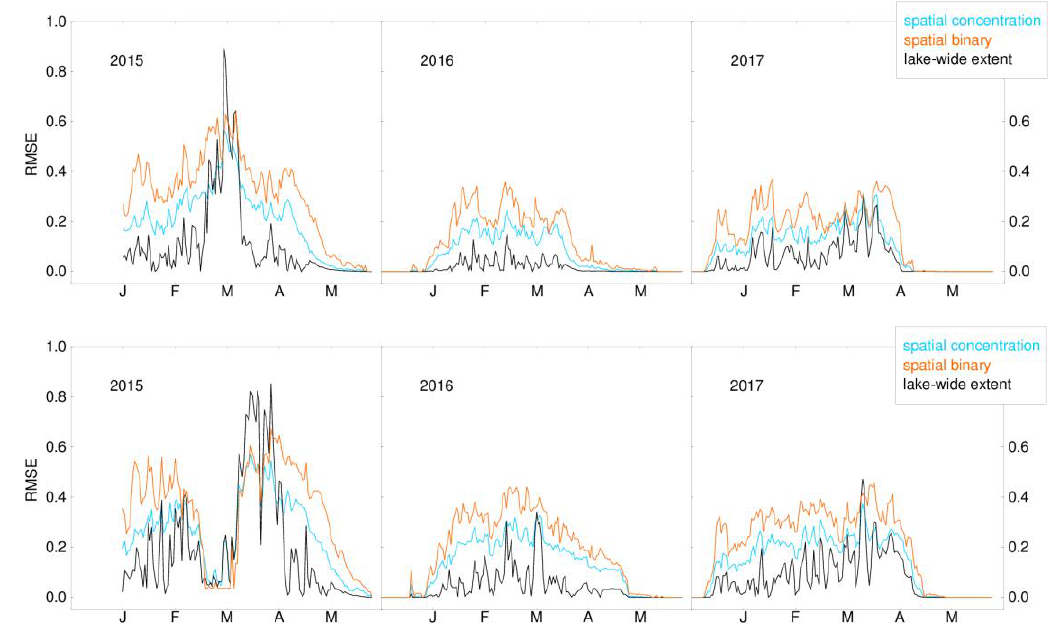
Figure 7. Time series of ice simulation errors between the Lake Michigan-Huron model and the NIC based on the three methods for ( top ) Lake Michigan and ( bottom ) Lake Huron: Pixel-to-pixel RMSE based on ice concentration (cyan), pixel-to-pixel RMSE based on binary ice cover (orange), and lake-wide absolute error (black). Please note that lake-wide absolute error shows only the magnitude of error (i.e., does not show the sign of model bias).